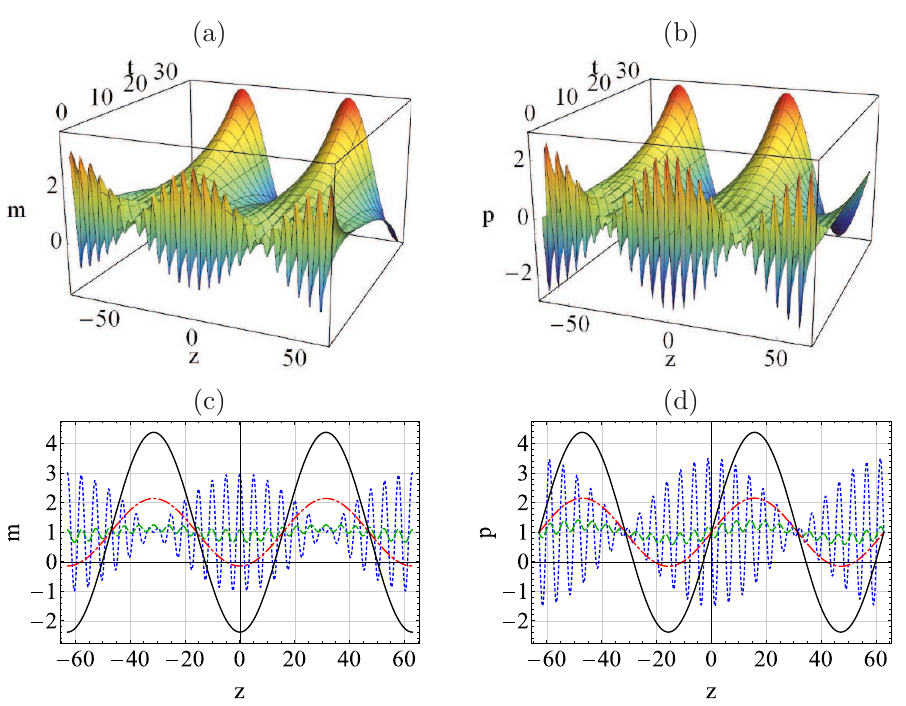
Figure 3 . Three-dimensional plots of (a) 1+ m 1 ( t, z )+ m 2 ( t, z ) and (b) p 1 ( t, z )+ p 2 ( t, z ), given by eqs. (2.43), (2.44), (2.49), and (2.50) with N = 2 , a 1 = a 2 = 1 , k 1 = 1 . 3 , k 2 = 1 . 2 , ϕ 1 = ϕ 2 = 0. Snapshots of (c) 1+ m 1 ( t, z )+ m 2 ( t, z ) and (d) p 1 ( t, z )+ p 2 ( t, z ) at t = 0 (blue dotted), t = 8 (green dashed), t = 28 (red dot-dashed), and t = 40 (black